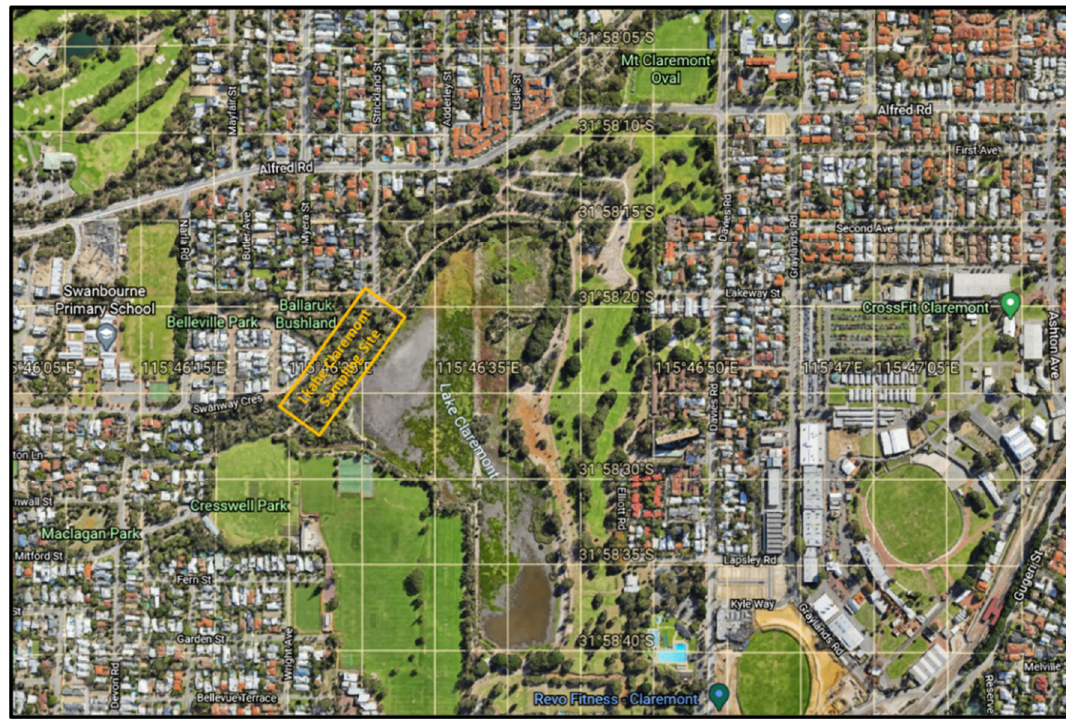
Figure A3. Location of the sampling site at Lake Claremont (source: Google Earth [90]).